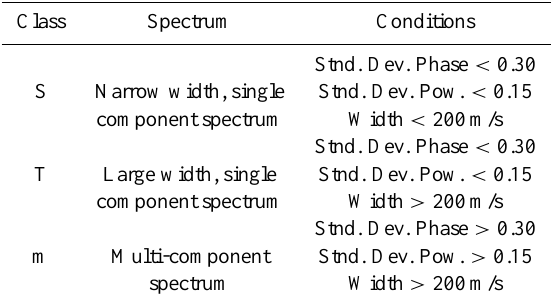
Fig. 2. Mean value of the (a) ACF spectral width, (b) errors on the fit per- formed on the ACF phase and (c) er- rors on the fit performed on the ACF power. The black line represents the av- erage position of the poleward bound- ary of the auroral oval, as modelled by Holzworth and Meng (1975) for moder- ate magnetic activity. Table 1. Characteristics of the three classes of ACF according to the spectral width and standard deviation on phase and